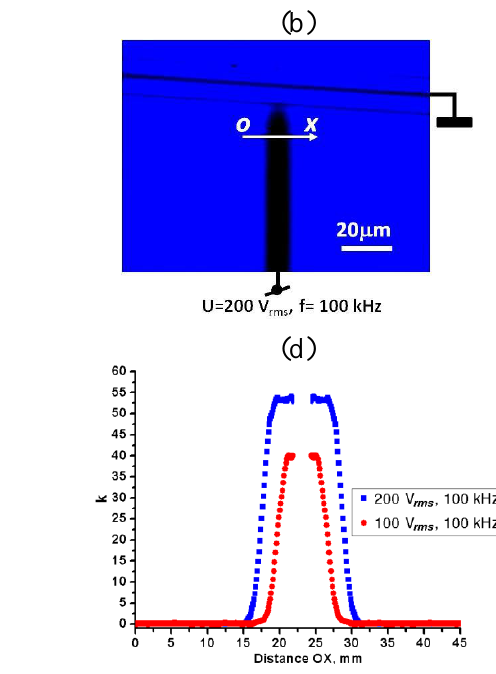
Figure 5. Optical microscope textures of the toluene dispersion of “short/ thin” Au NRs in the flat cell when the field 𝐄 intensities (c) and local filling factors ratio 𝑘 𝑙𝑛10) , measured in a monochromatic (460 nm) linearly polarized light (d)